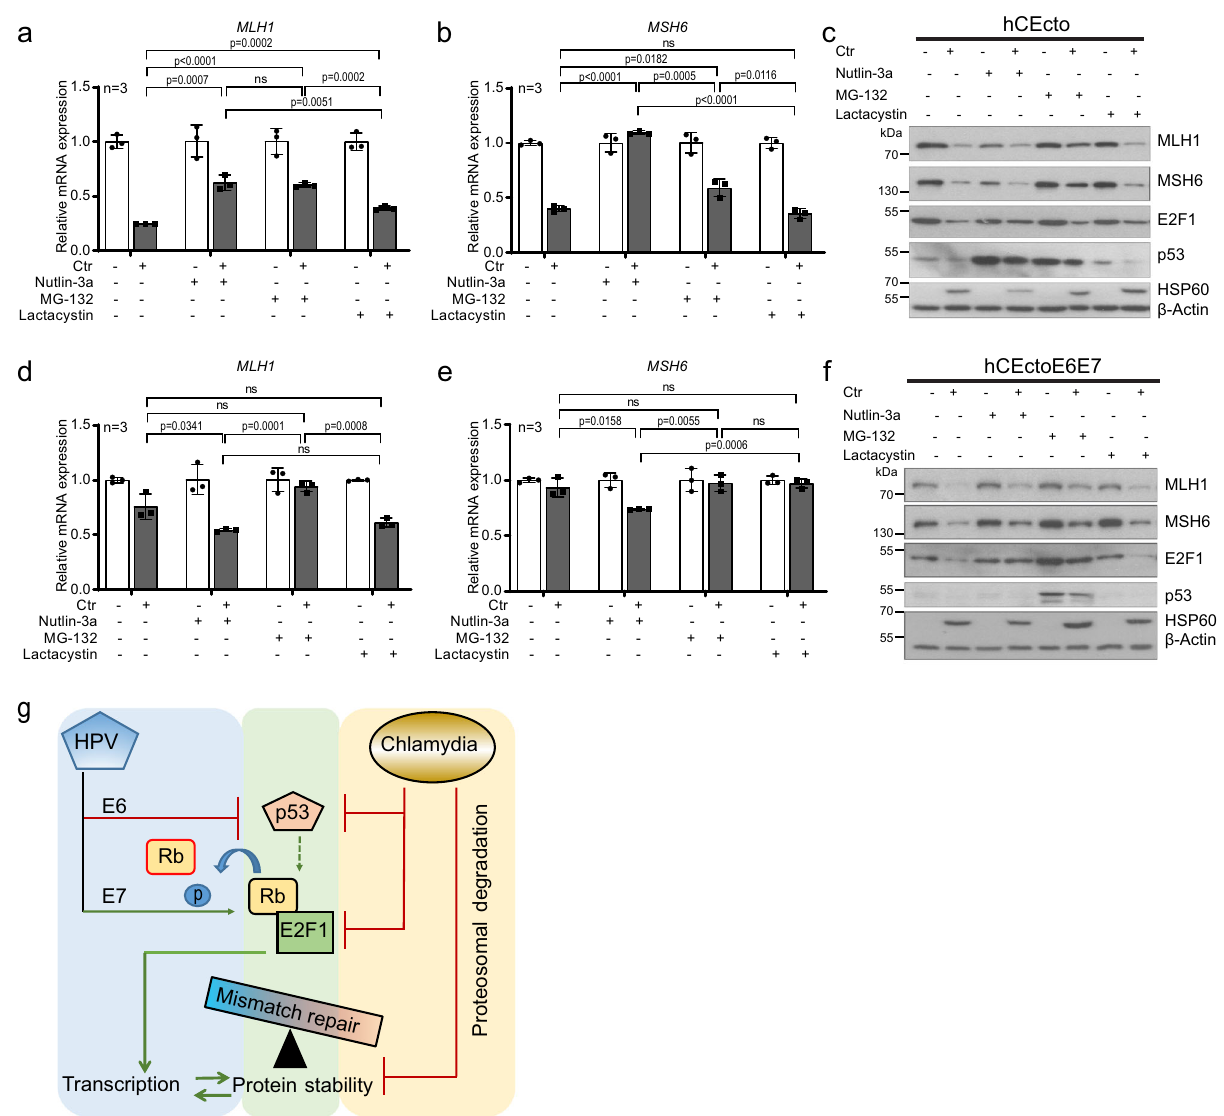
Fig. 5 Chlamydia and HPV E6E7 coinfection regulates MMR distinctly at transcriptional and translational levels. hCEcto and hCEcto E6E7 2D stem cells were infected with Ctr for 48 h with or without additional treatment with Nutlin-3a (10 µ M) or Lactacystin (10 µ M) from 2hpi or 24hpi with MG-132 (5 µ M). a , b Shown is the relative mRNA expression of MLH1 ( a ) and MSH6 ( b ) analyzed by qRT-PCR from hCEcto cells. Data represent mean ± SD of three replicates normalized to uninfected controls from a representative of two independent experiments. Statistical signi fi cance was calculated using two-sided t test, P -values are indicated; ns, no signi fi cance. (c) Immunoblot analysis of lysates from hCEcto cells for indicated proteins and Chlamydia HSP60 and β - actin as a loading control. d , e Shown is the relative mRNA expression of MLH1 ( d ) and MSH6 ( e ) analyzed by qRT-PCR from hCEcto E6E7 cells. Data represent mean ± SD of three replicates normalized to uninfected controls from a representative of two independent experiments. Statistical signi fi cance was calculated using two-sided t test, P -values are indicated; ns, no signi fi cance. f Immunoblot analysis of lysates from hCEcto E6E7 cells for indicated proteins and Chlamydia HSP60 and β -actin as a loading control. Data from ( c ) and ( f ) represent two biological replicates. g Model depicting the mechanistic regulation of MMR by HPV E6E7 and Chlamydia infections. Source data are provided as a Source Data fi